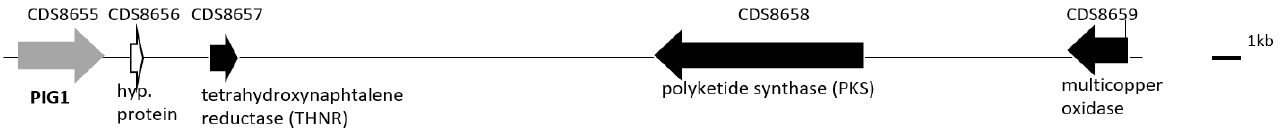
Figure 1. Gene cluster of melanin biosynthesis in S. apiospermum (36.1 kb), from the published S. apiospermum genome [30]. The scytalone deshydratase encoding gene is located out of the cluster.